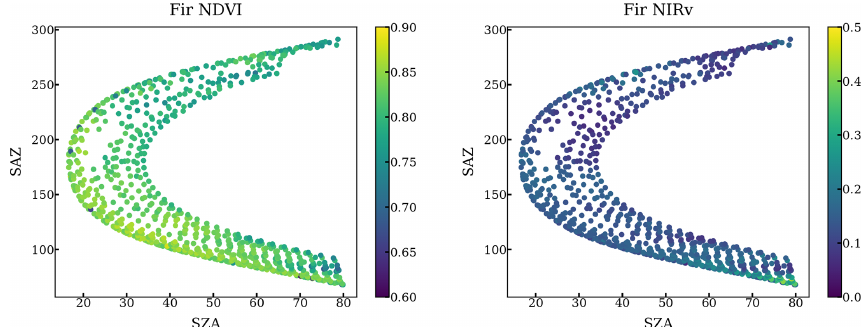
Figure A2. NDVI and NIRv of all scans targeting a fir at different solar azimuth angles and solar zenith angles throughout a year.